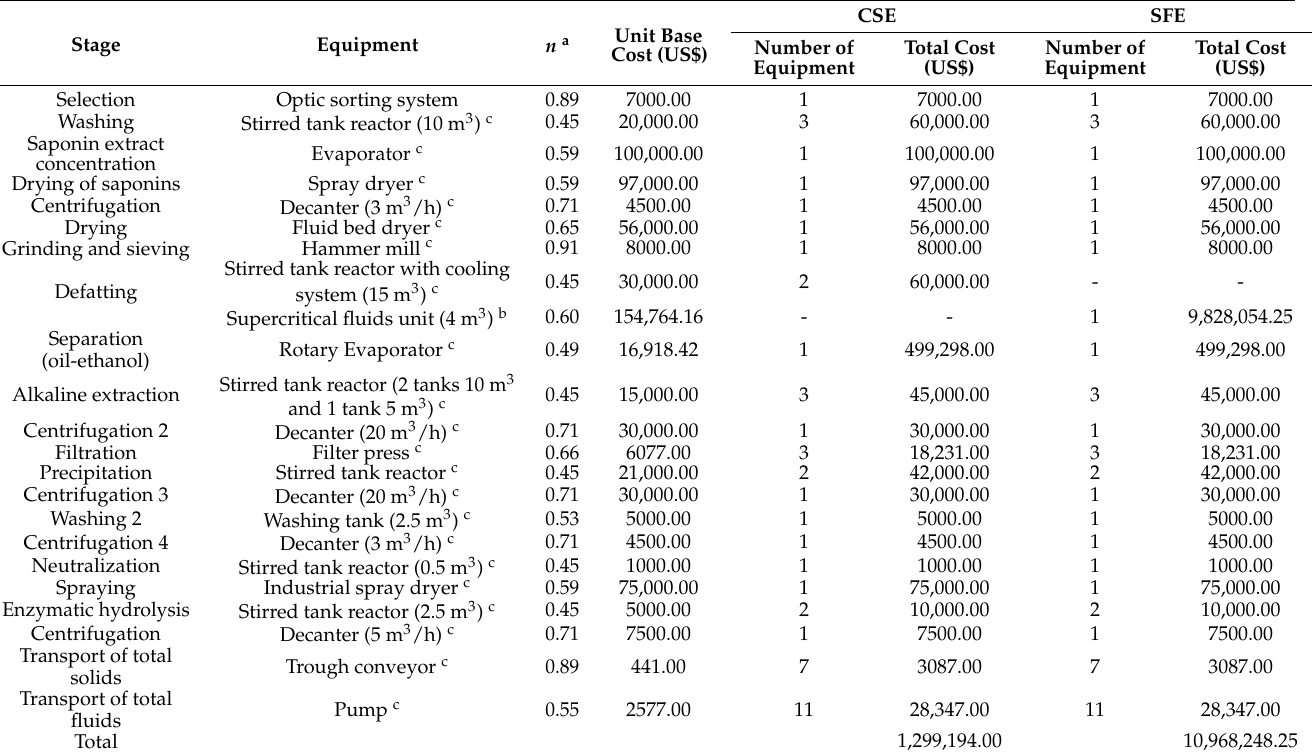
Table 2. Base cost for each plant for production of QPH using supercritical fluids’ extraction (SFE) and conventional solvent extraction (CSE).